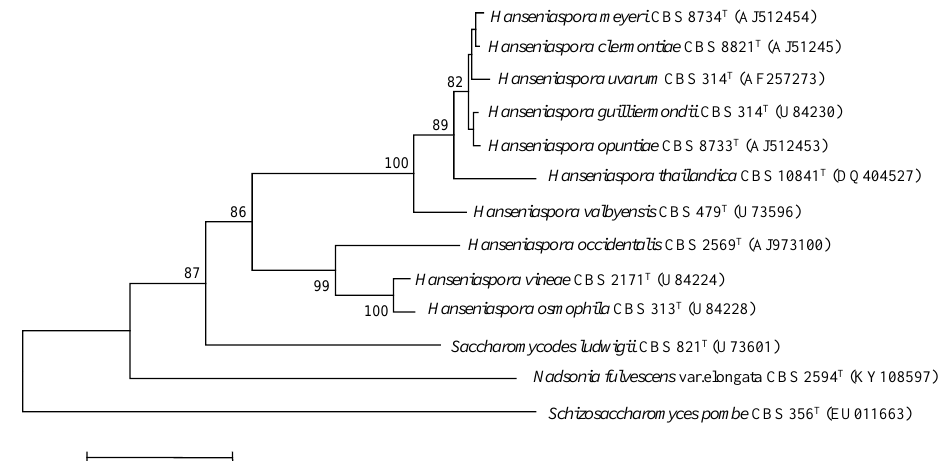
Figure 2. Phylogenetic relationships between type strains of Hanseniaspora species and other grape or wine-related apiculate yeasts. The dendrogram was constructed using partial 26S rRNA gene sequences by the neighbor-joining method. The robustness of the branching is indicated by bootstrap values (%) calculated for 1000 subsets. The entries of the different genotypes include the accession numbers of the GenBank database sequences. Schizosaccharomyces pombe type strain was used as an outgroup.